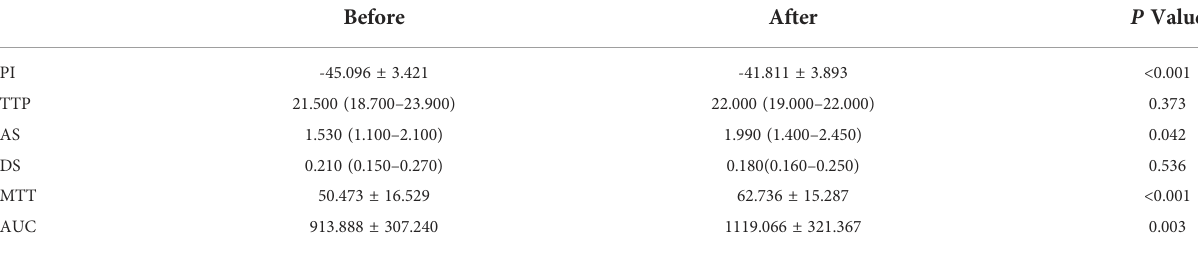
TABLE 4 Comparison of quantitative parameters of CEUS TIC curve before and after ultrasound therapy.